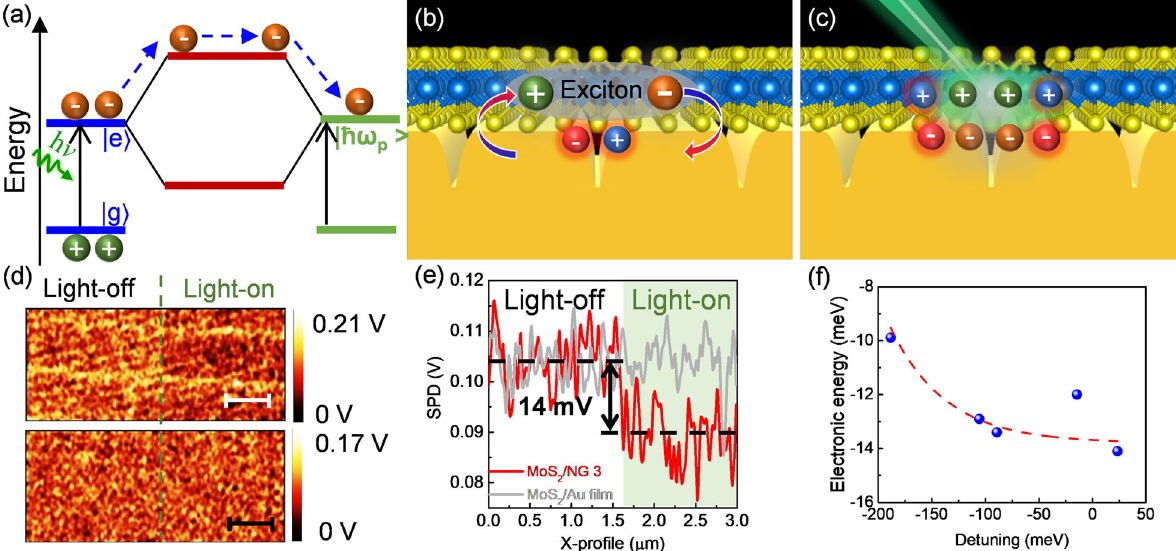
Fig. 4 SP change in intermediate coupling system. a Schematic illustration of photo-excited carriers ’ transfer process in intermediate coupling system. The illustration of electronic energy exchange in the intermediate coupling system with light-off ( b ) and light-on ( c ). d KPFM mapping image of MoS 2 /NG3 (top panel) and MoS 2 /Au fi lm (bottom panel). The green dashed line indicates the place started illumination at 532 nm. The scale bars are 500 nm. e The SP pro fi le of MoS 2 /NG3 and MoS 2 /Au fi lms. These data were extracted from ( d ) and averaged for every column. The green marked area indicates the 532 nm light illumination during the measurement. f The blue dots are the measured electronic energy of intermediate coupling system as a function of detuning correspond to KPFM results. The red dashed line is the exponential decay fi tting curve.